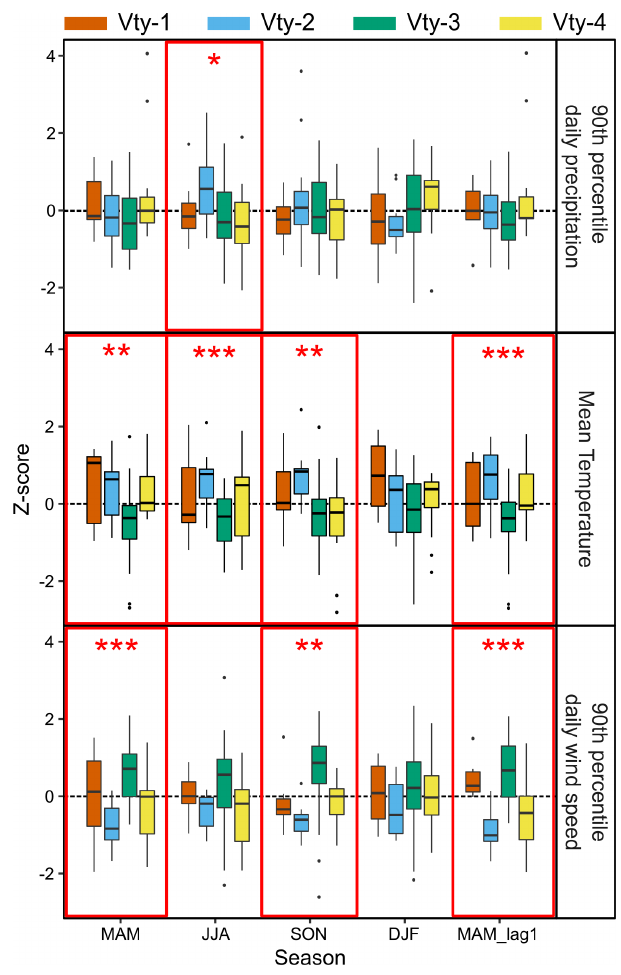
Figure 5. Boxplots of seasonal meteorological variables separate by varve types (Vty). Red boxes and * symbols indicate meteo- rological variables with significantly ( p< 0 . 05) different means for the four Vtys, based on an analysis of variance test (* p< 0 . 1, ** p< 0 . 05, *** p< 0 .